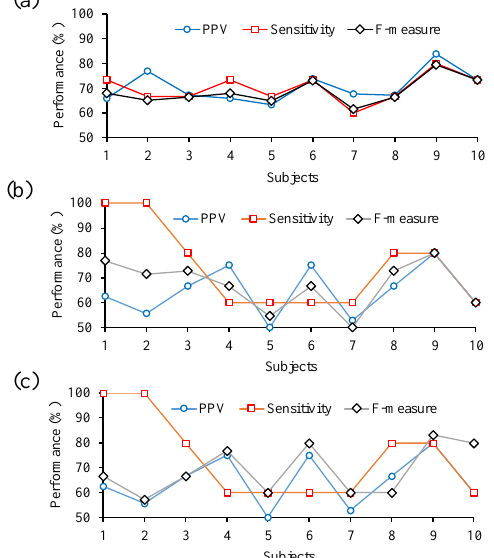
Figure 9. Experimental results for PPV, sensitivity, and F-measure of detecting ( a ) all motor imagery; ( b ) right hand motor imagery; and ( c ) left hand motor imagery.